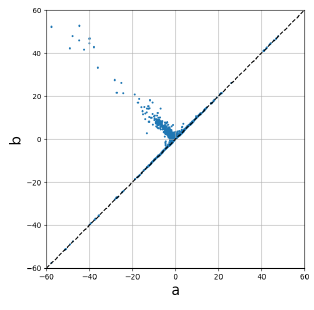
Figure A4. Relaxed passenger with rigid seat.